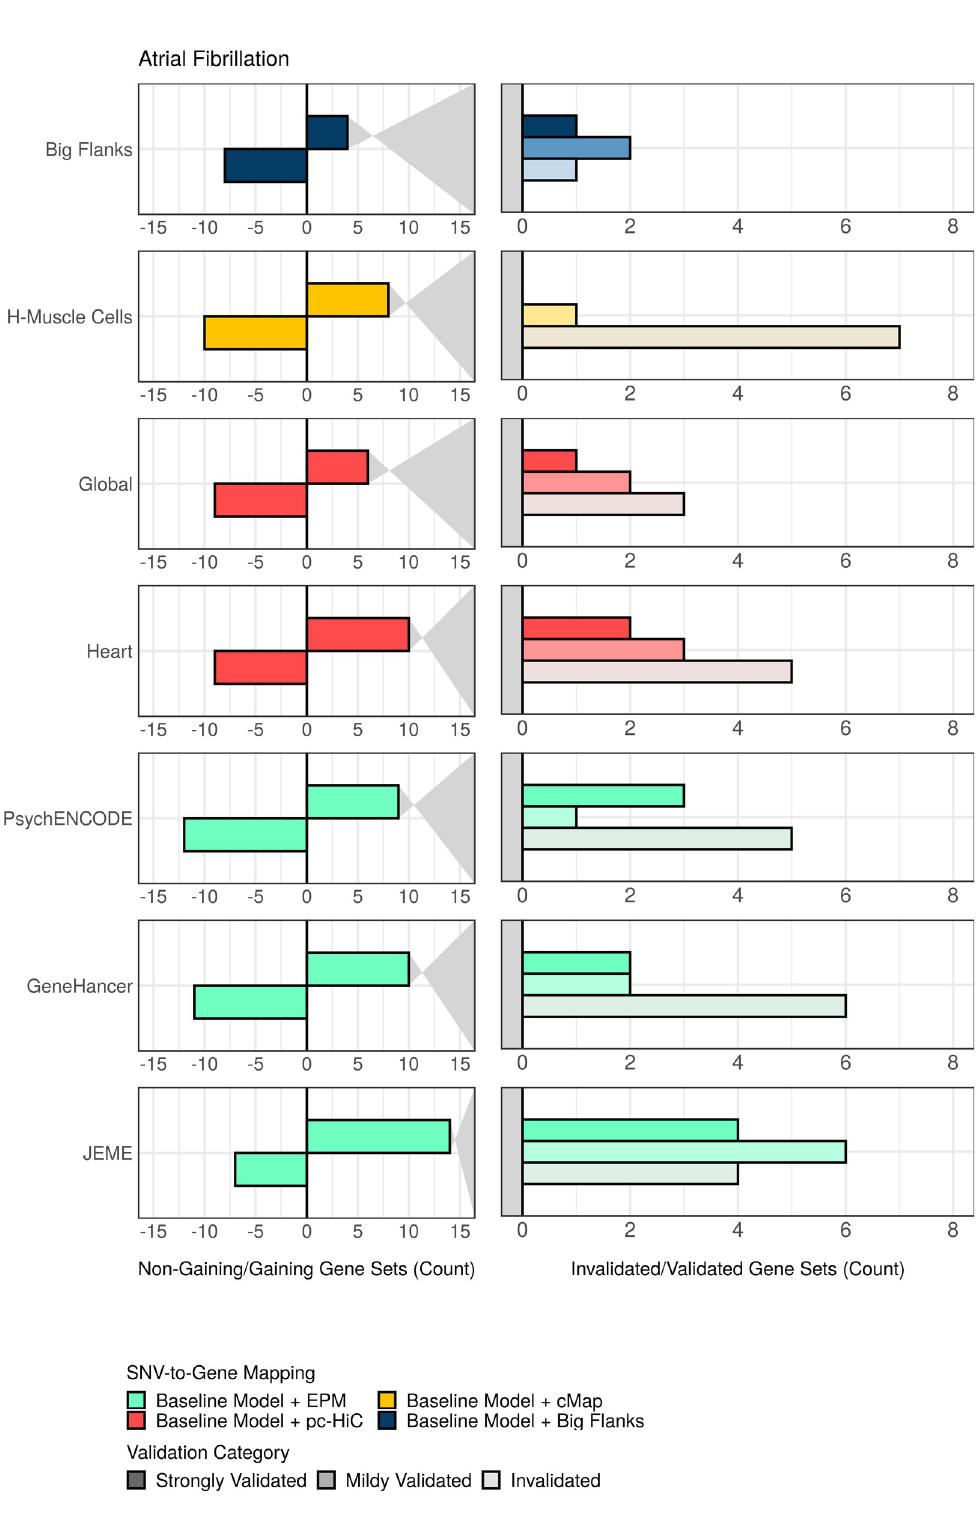
Fig 6. Significant gene sets that gain from augmentation, often gain no more from genuine augmentation than from matched, random augmentation. Left panel: the numbers of gaining (bars directed rightwards and positive values) and non-gaining (bars directed leftwards and negative values) gene sets amongst significant gene sets detected for